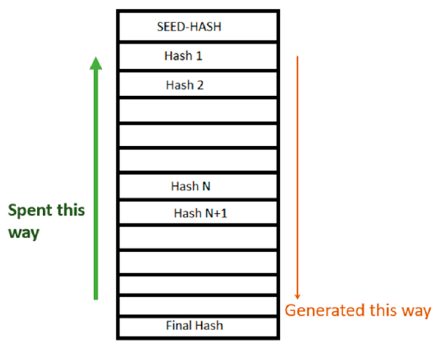
Figure 11. Releasing tokens from a Token